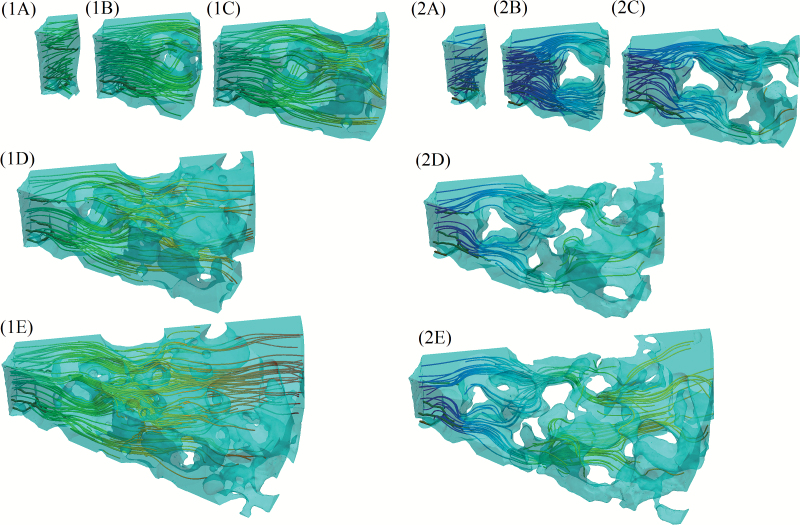
Typical plots obtained from simulation for the saturated case (1A–E). and the partially saturated case (2A–E). The five images in each case correspond to θ=0.2 θmax=π/5, and h=0.2hmax=0.36 mm for (A) r=0.2rmax=0.352 mm, (B) r=0.4rmax=0.704 mm, (C) r=0.6rmax=1.056 mm, (D) r=0.8rmax=1.408 mm, and (E) r=1.0rmax=1.76 mm. The streamlines show the effective diffusion paths, with red corresponding to high nutrient concentration and blue corresponding to lower nutrient concentration. (This figure is available in colour at JXB online.)